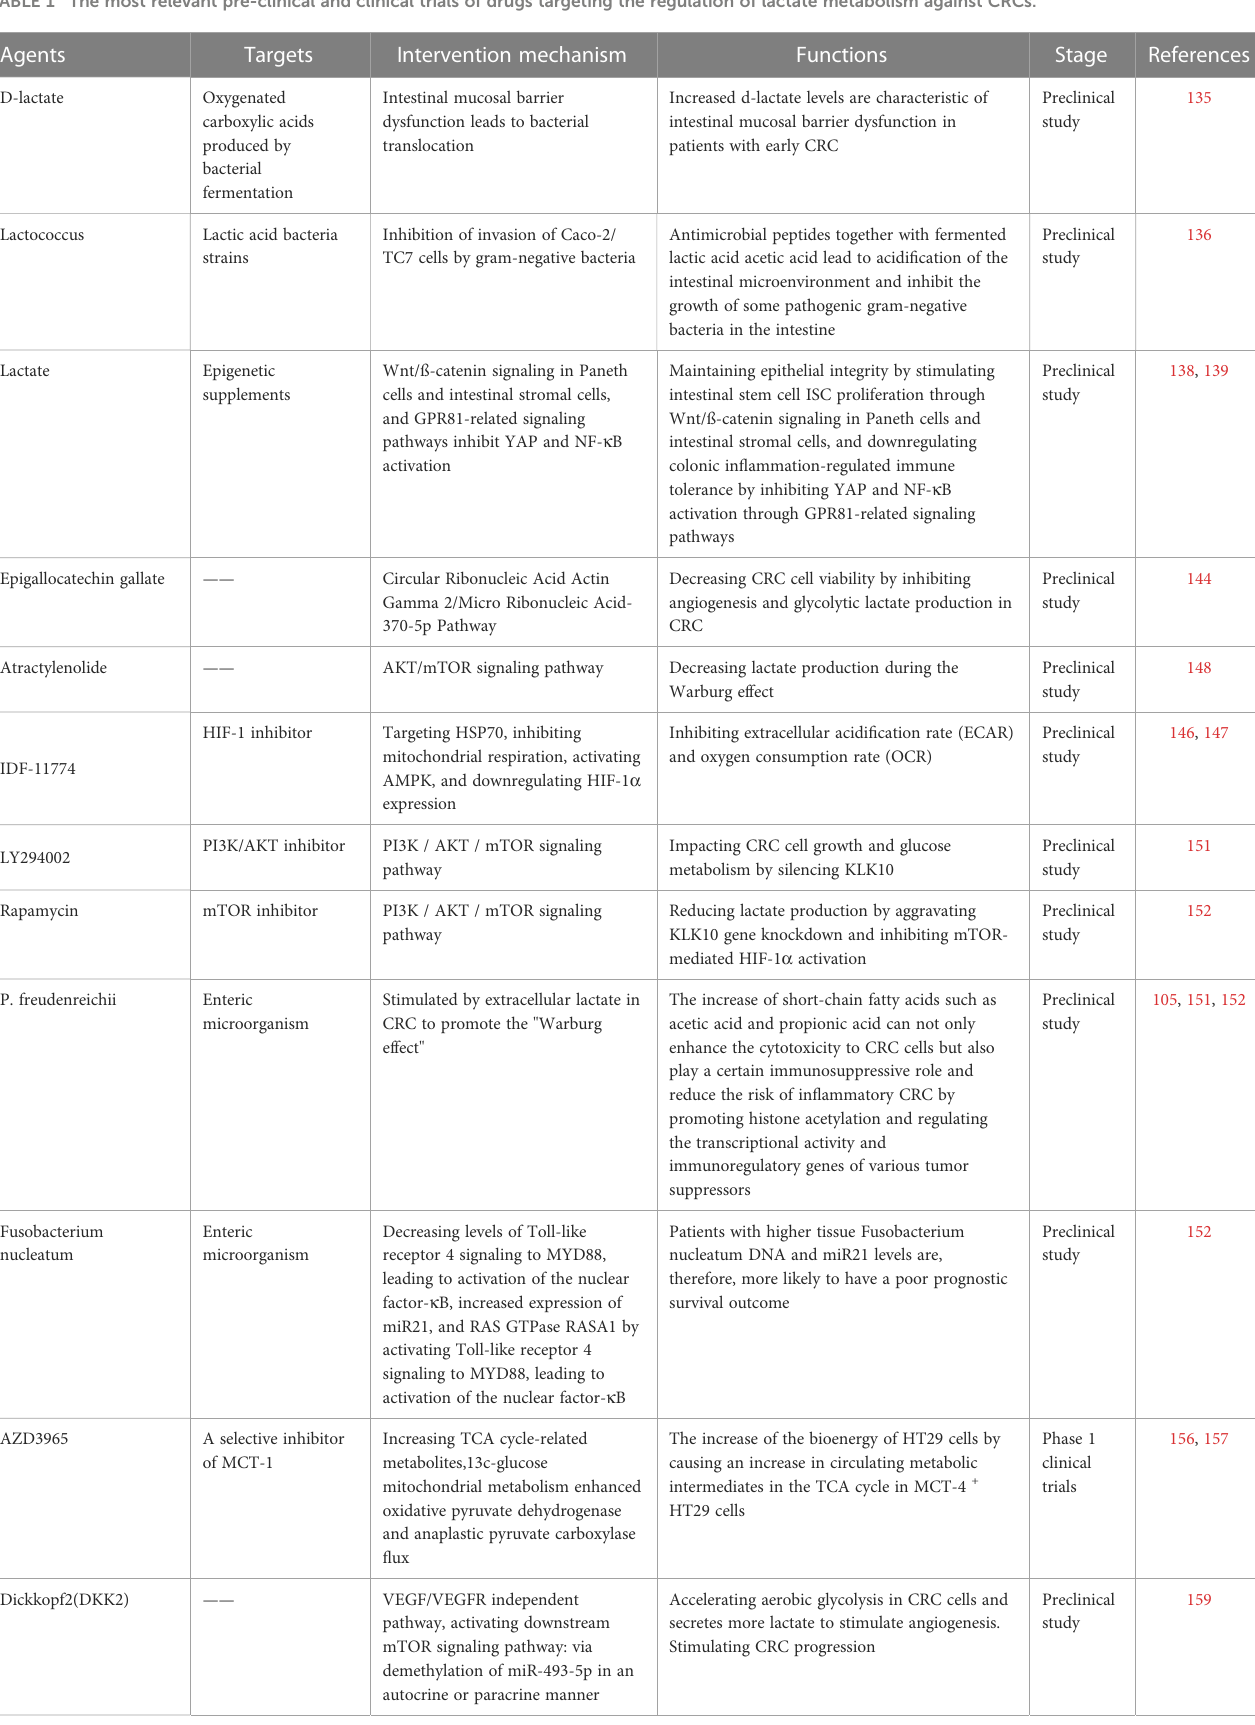
TABLE 1 The most relevant pre-clinical and clinical trials of drugs targeting the regulation of lactate metabolism against CRCs.